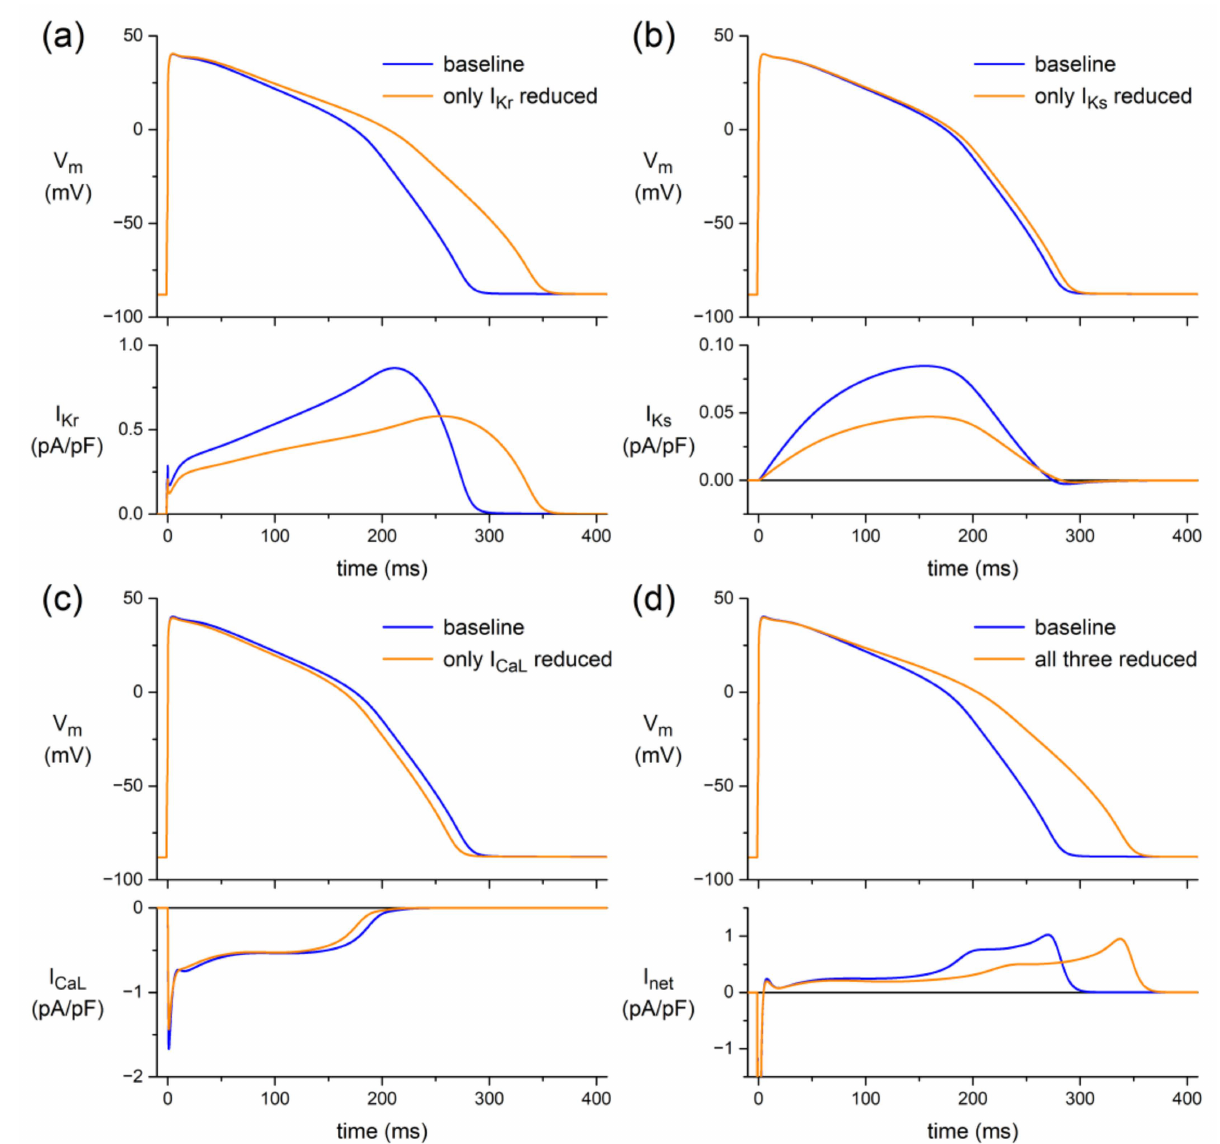
Figure 5. Effects of ACh-induced changes in the L-type Ca 2+ current (I CaL ) and the rapid and slow delayed rectifier K + currents (I Kr and I Ks , respectively) on the electrical activity of the O’Hara–Rudy human ventricular cell model [44] at 1 Hz. ( a ) Membrane potential (V m ; top) and associated I Kr (bottom) if ACh affects only I Kr . ( b ) V m (top) and associated I Ks (bottom) if ACh affects only I Ks . ( c ) V m (top) and associated I CaL (bottom) if ACh affects only I CaL . ( d ) V m (top) and associated net membrane current (I net ; bottom) if ACh affects all three currents, i.e., I CaL , I Kr , and I Ks . Note differences in current